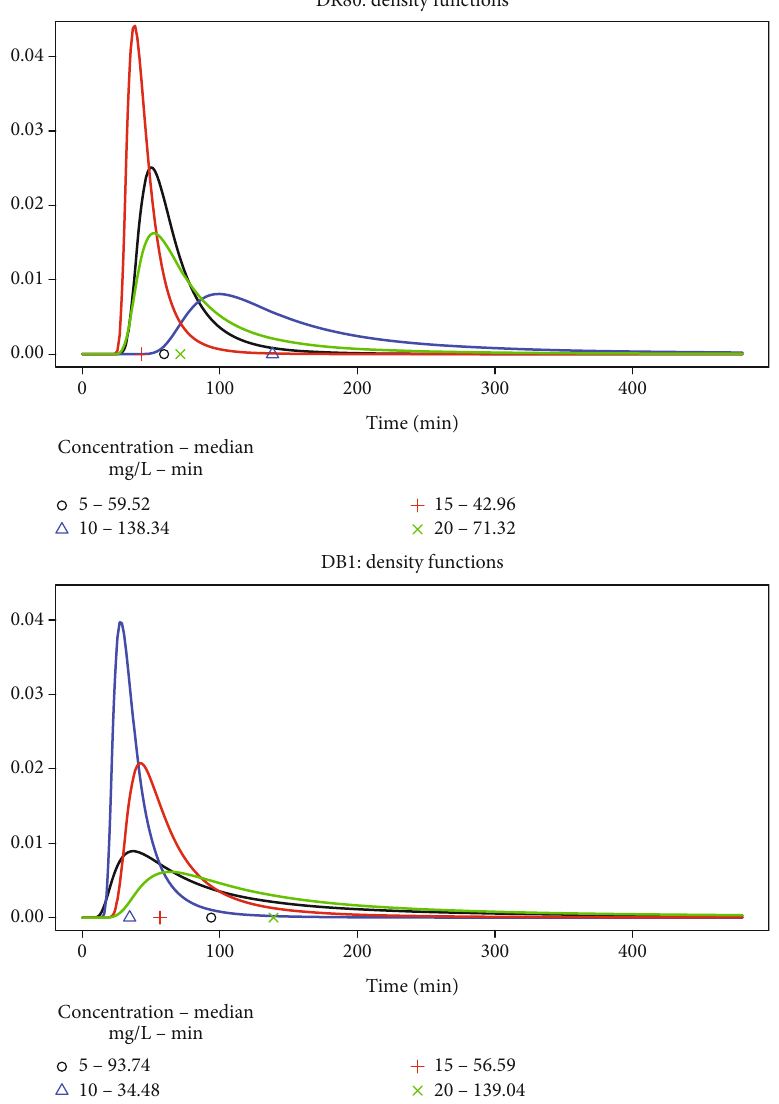
Figure 4: Density functions of the time ( t concentrations (5, 10, 15, and